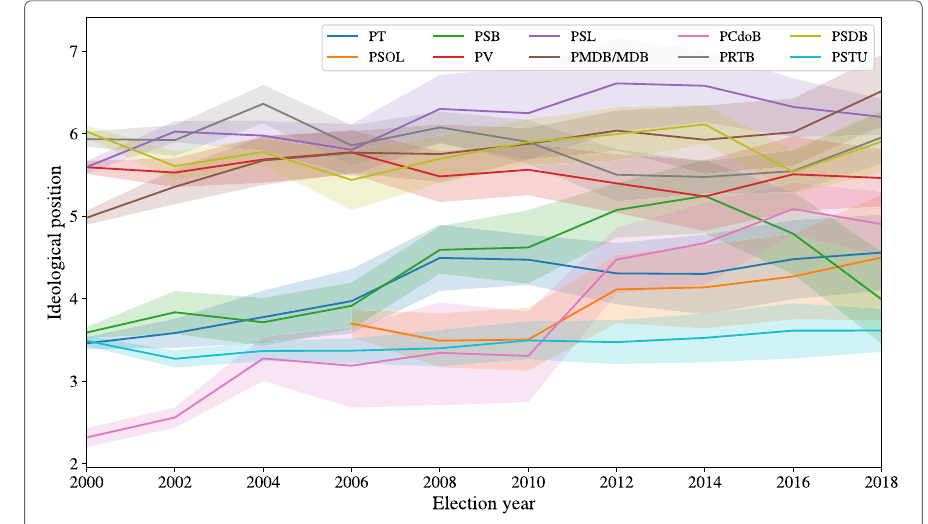
Fig. 5 Positions of political parties. The starting points from Zucco and Power (Power and Zucco Jr 2009) (Additional file 1: Table S1) are from the election year of 1998. The points shown for year 2000 are already computed from our model. The points of interest are the location of the party in any election year. The error of each score is shown with the same color in higher transparency. Movements to the left or to the right along the ideological spectrum represents the dynamics of the churn rate of members in any election year. The stability of a party to its current ideology depends on the number of loyal and newly acquired